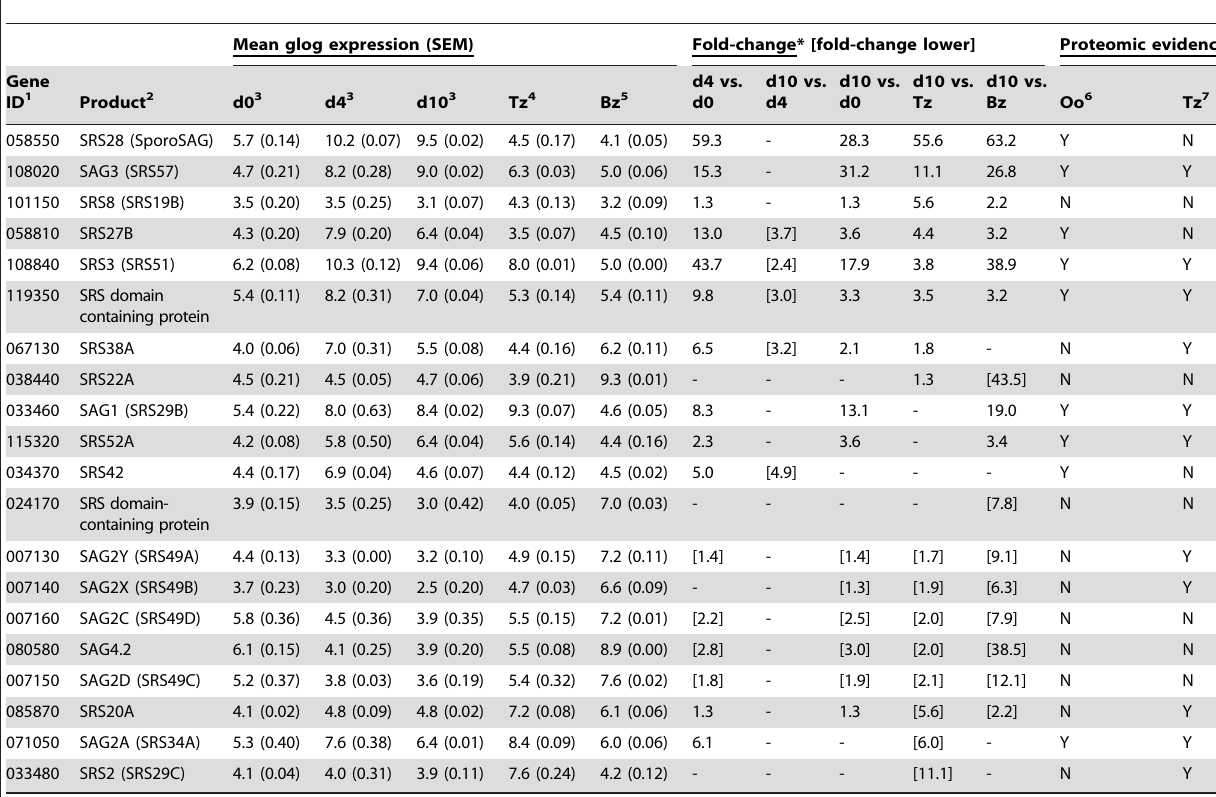
Table 4. Expression of functionally interesting genes of Toxoplasma gondii oocysts at different stages of maturation with a comparison to bradyzoite and tachyzoite expression levels - SRS family